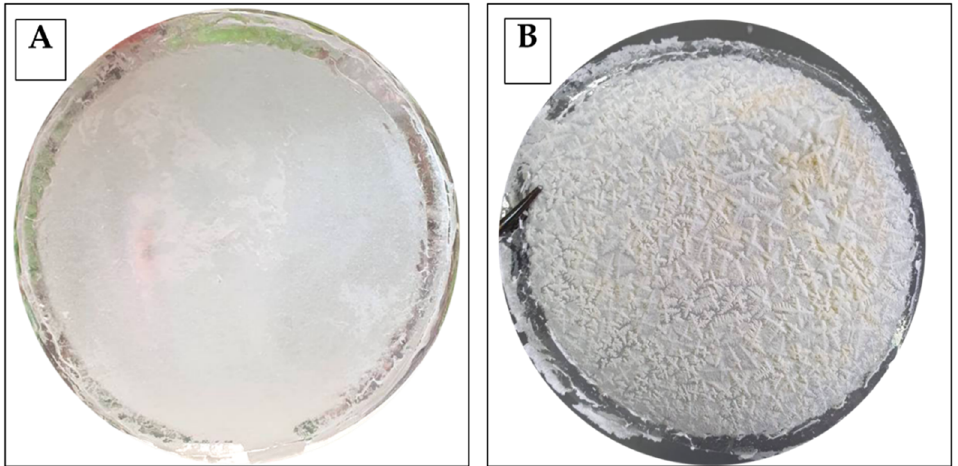
Figure 1. Films obtained by using 2.5% CNF mixture and PLA. Control film ( panel A ); nisin-activated film ( panel B ).